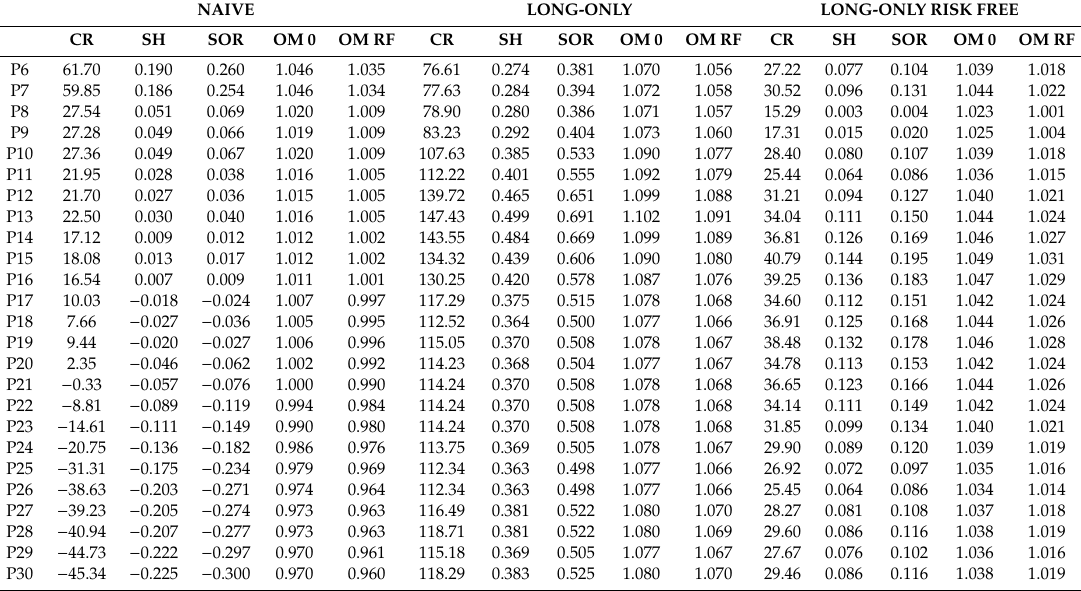
Table 10. Performance from responsible portfolios using a 3-year rolling window considering transaction costs.